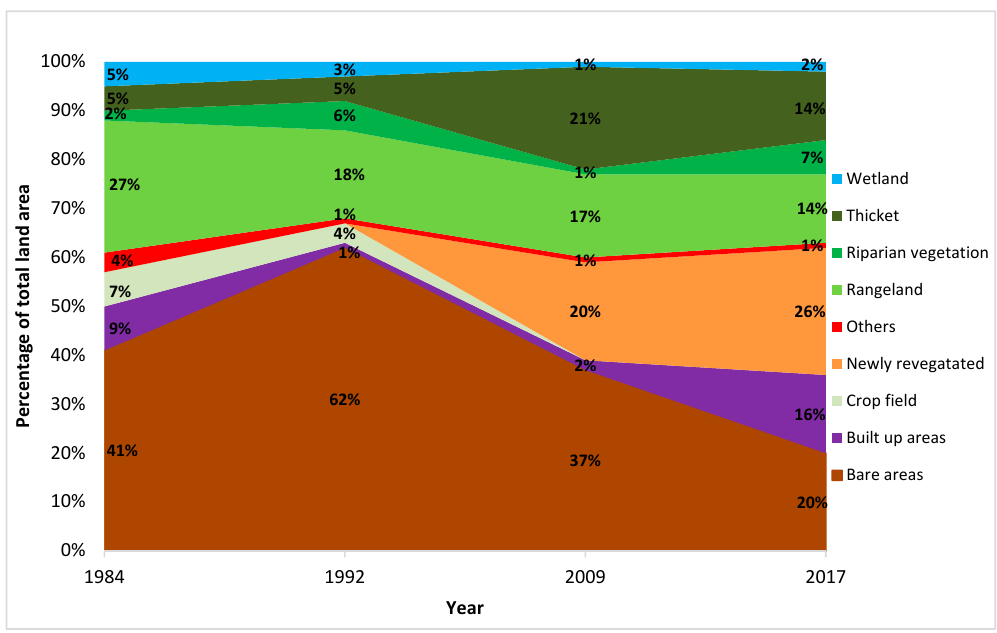
Figure 2. The change in land cover of Amakhala game reserve from 1984 to 2017.